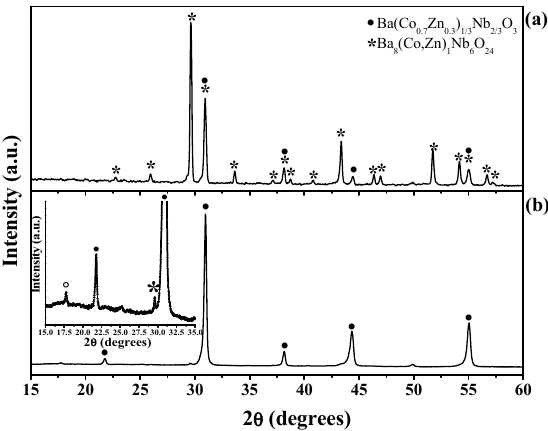
Figure 2. X-ray diffractograms of a BCZN ceramic ( S1 ): ( a ) at the upper surface and ( b ) at a depth of 90 µm below the surface. •: Ba(Co 0.7 Zn 0.3 ) 1/3 Nb 2/3 O 3 ; * : Ba 8 (Co,Zn) 1 Nb 6 O 24 .